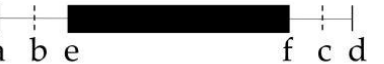
Figure 6. The measuring illustration of the length of the substitution fragment. (b and c were the median values of a and e, f and d, respectively).